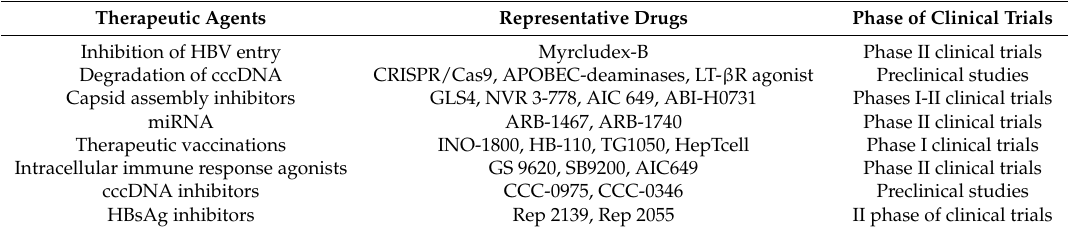
Table 1. Novel therapeutics for chronic hepatitis B